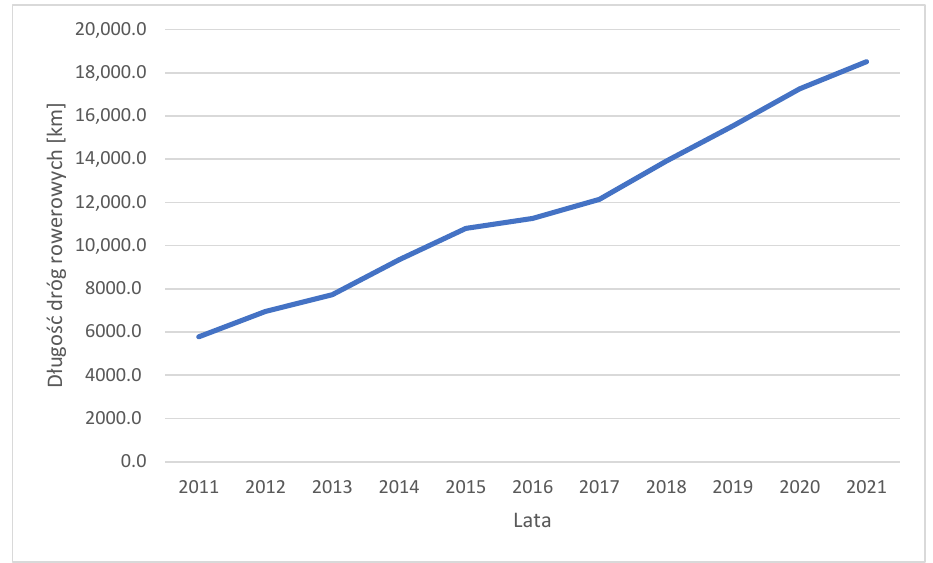
Figure 2. Change in the length of bicycle roads in Poland in years 2011–2021. Source: Author own analysis.